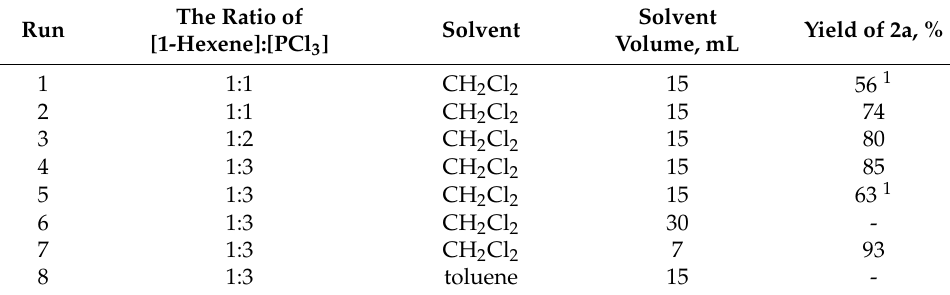
Table 1. Optimization of the reaction for the preparation of 2a . Run